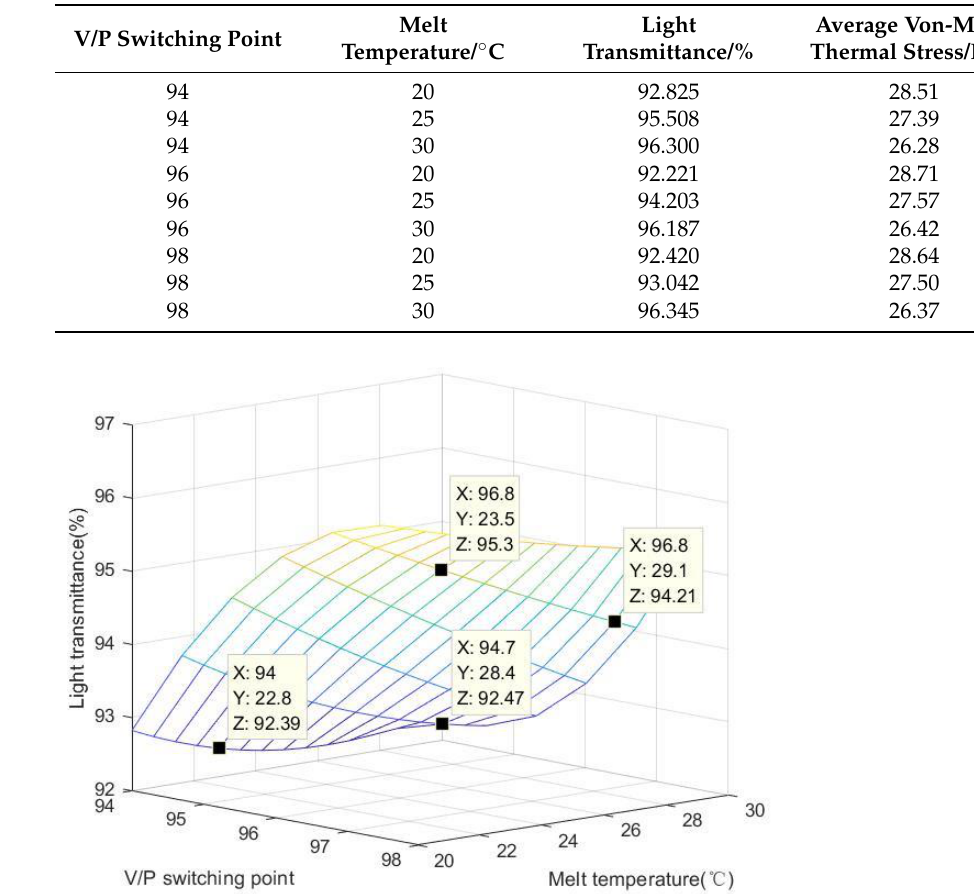
Table 6. Average Von-Mises thermal stress changes with melt temperature.